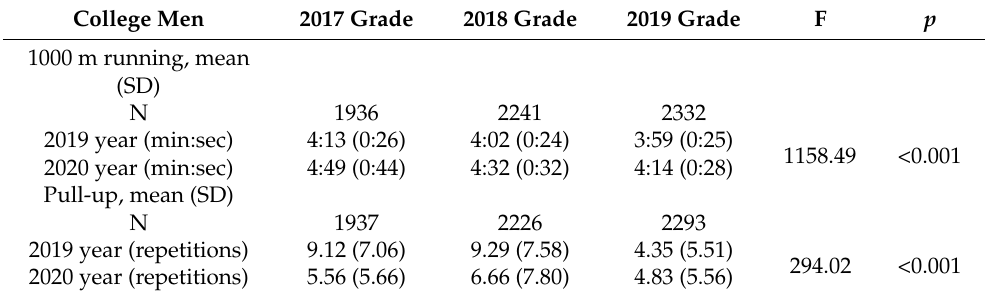
Table 2. College men’s physical fitness performance differences pre- and post-COVID-19 lockdown by grade.